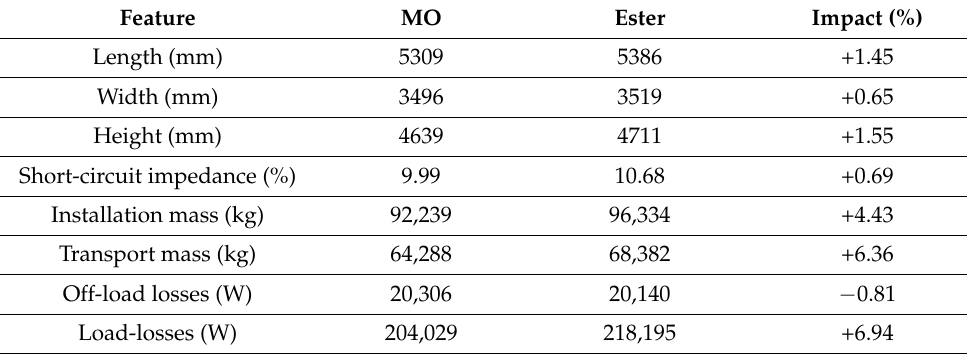
Table 5. Case 2—transformers’ final design.